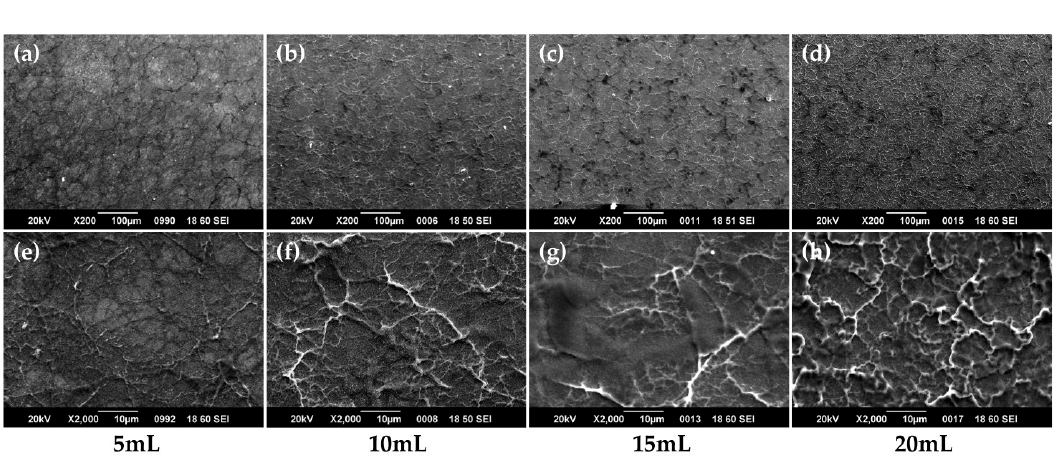
Figure 3. SEM images of the as-deposited films, before annealing ( a – d ) SEM micrographs of the 5, 10, 15, and 20 mL precursor quantities deposited films at 200× magnification (scale size 100 μ m); ( e – h ) SEM micrographs of the 5, 10, 15, and 20 mL precursor quantities deposited films at 2000× magnification (scale size 10 μ m).